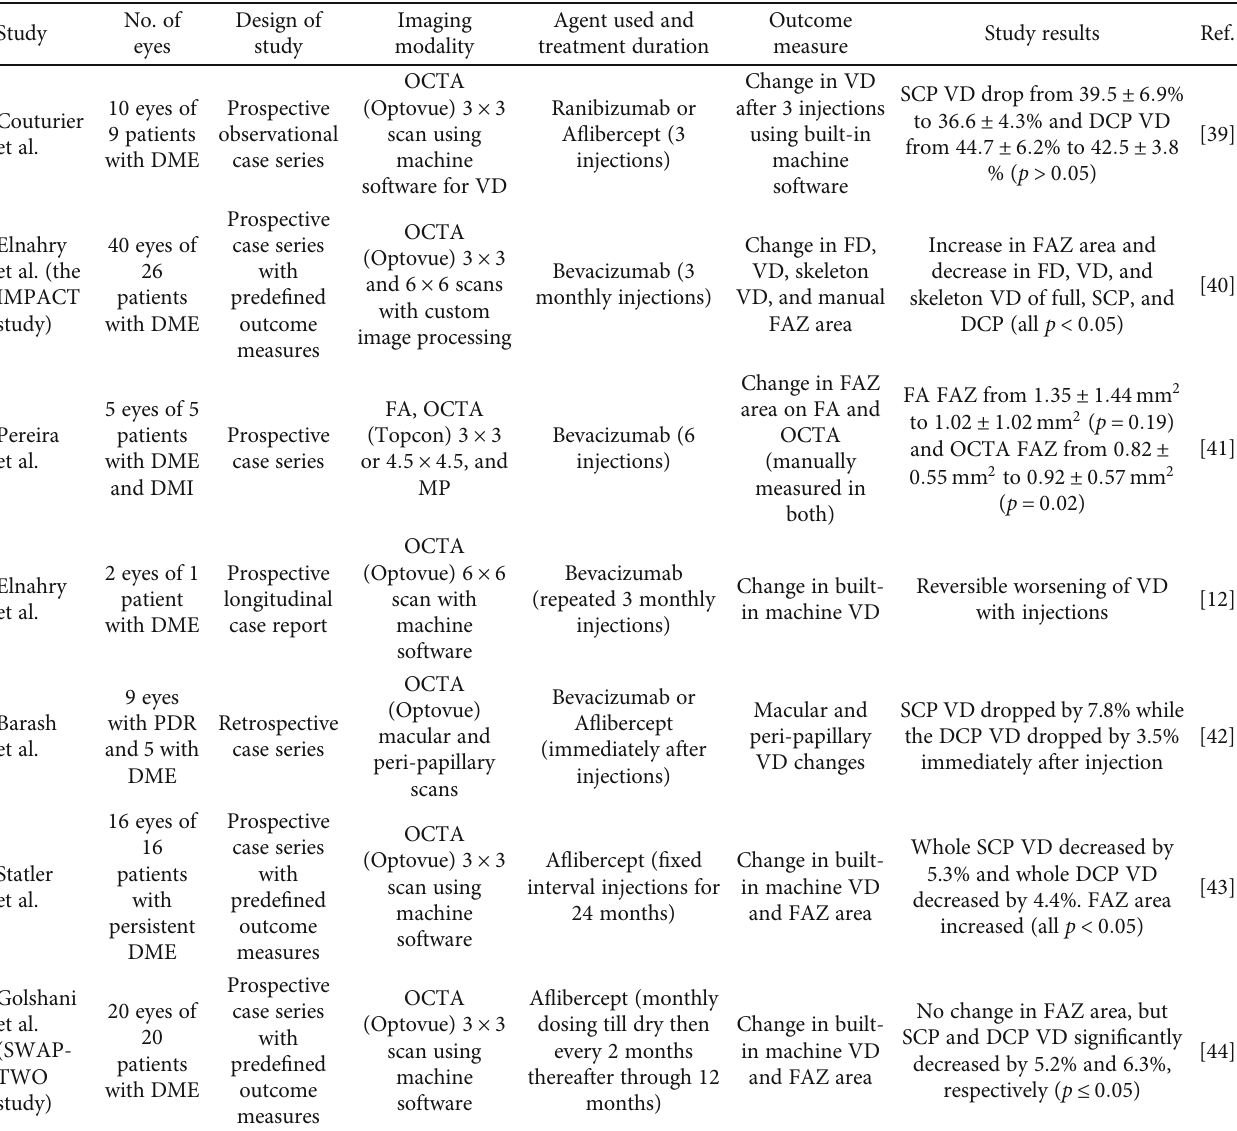
Table 2: Study design, methods, and results of studies that found worsening of macular perfusion following injections. Study